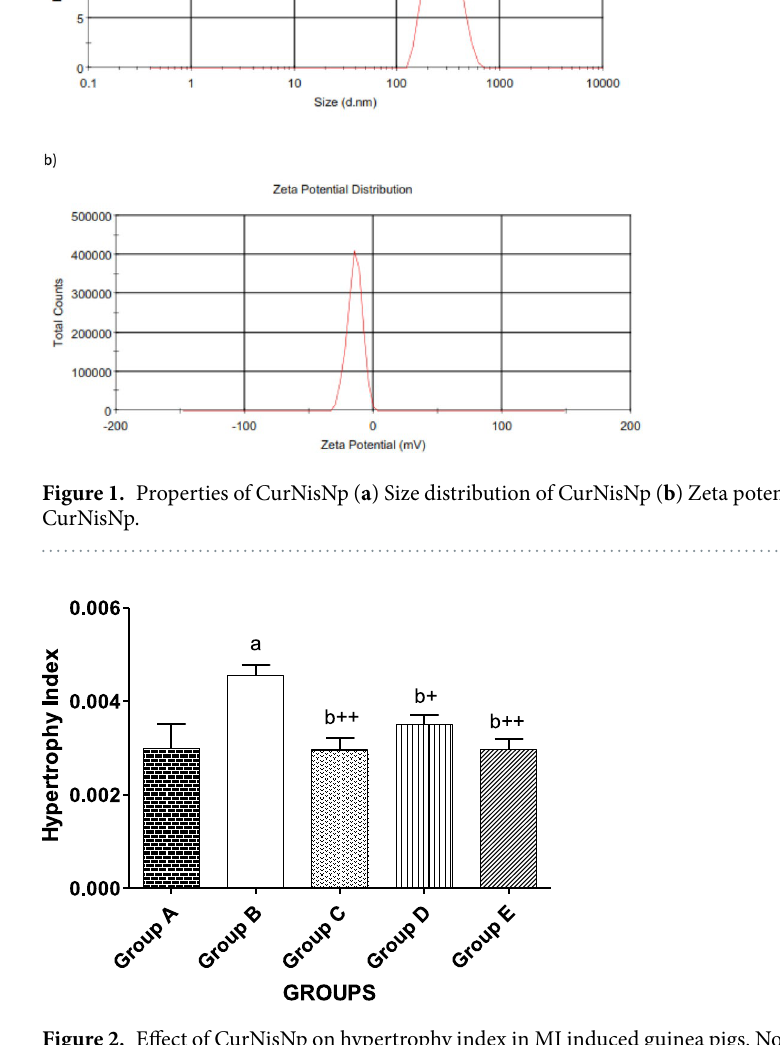
Figure 2. Effect of CurNisNp on hypertrophy index in MI induced guinea pigs. Note; data in bar chart are in Mean ± standard deviation. a P < 0.05 compared with group A; b + P < 0.01 compared with group B; b ++ P < 0.001 compared with group